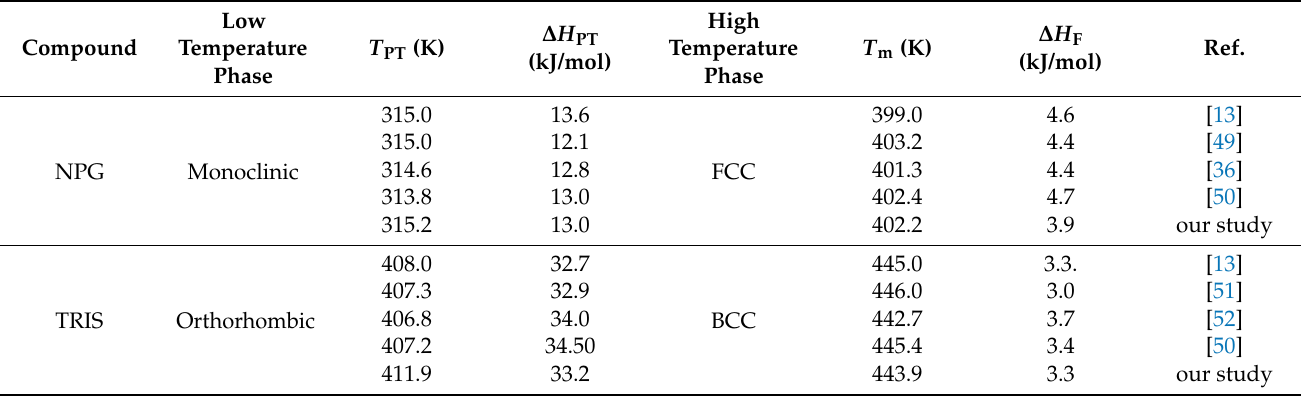
Table 2. Thermal properties and phase transitions of commercial NPG and TRIS samples handled under laboratory conditions. Literature data are also included in this